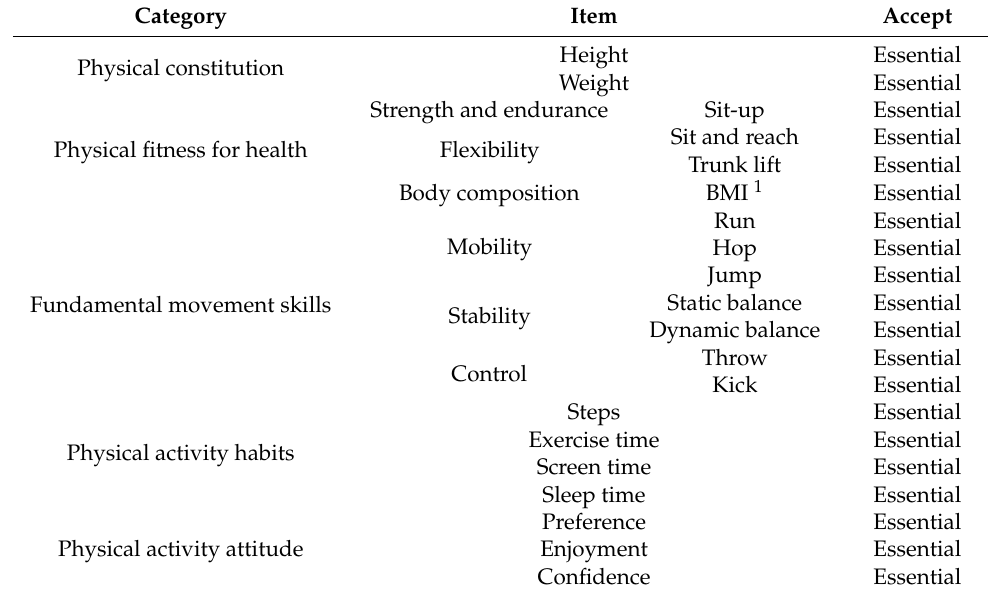
Table 3. Items for children physical activity competency test battery.